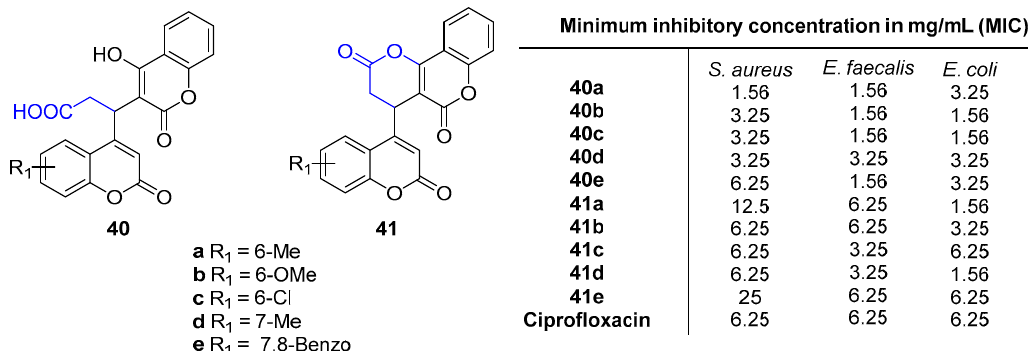
Figure 16. Coumarin dimer scaffolds proposed by Chougala and colleagues and the corresponding MIC values [80].